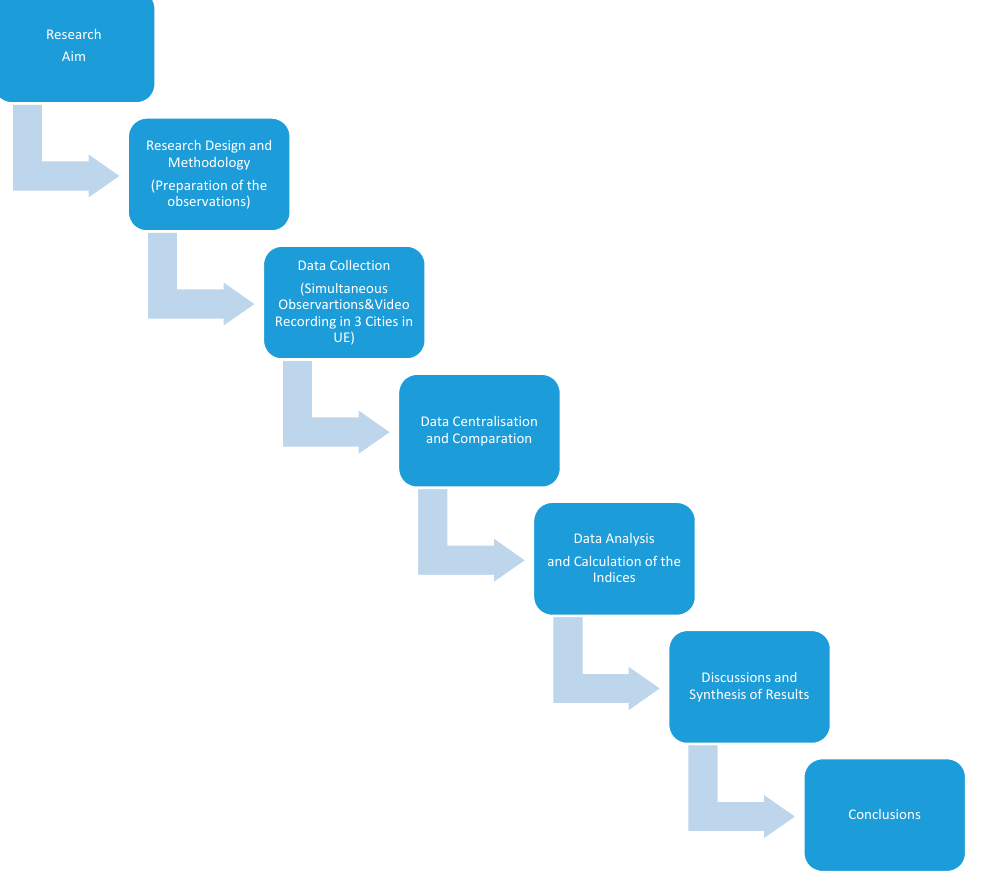
Figure 1. General framework of the methodology for the combined method. Source: own design.